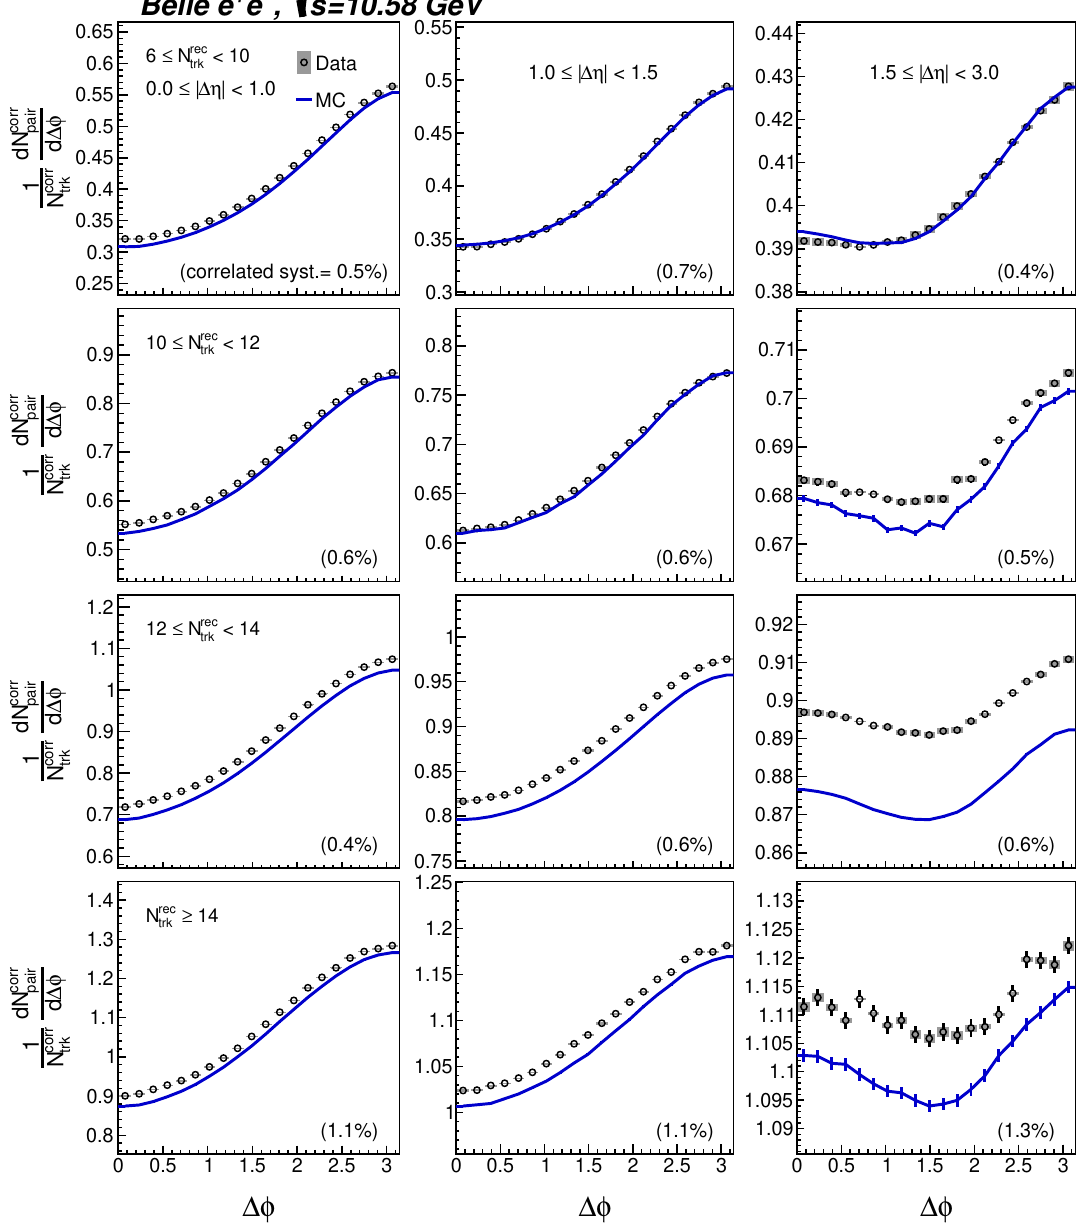
Figure 8. Thrust-axis azimuthal differential associated yields as a function of the reconstructed- track multiplicity N rec for the on-resonance sample in the short-range ( 0 ≤ | ∆ η | < 1 ), middle-range trk ( 1 ≤ | ∆ η | < 1 . 5 ) and long-range ( 1 . 5 ≤ | ∆ η | < 3 . 0 ) regions in columns from left to right,